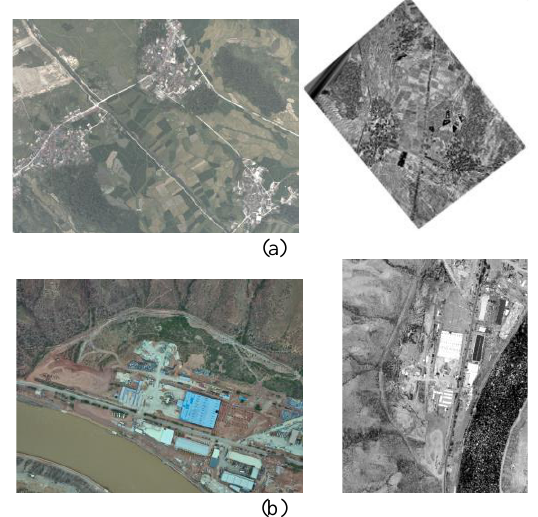
Figure 9. Experimental data. (a) Aerial and LiDAR intensity images of test 1. (b) Aerial and LiDAR intensity images of test 2.